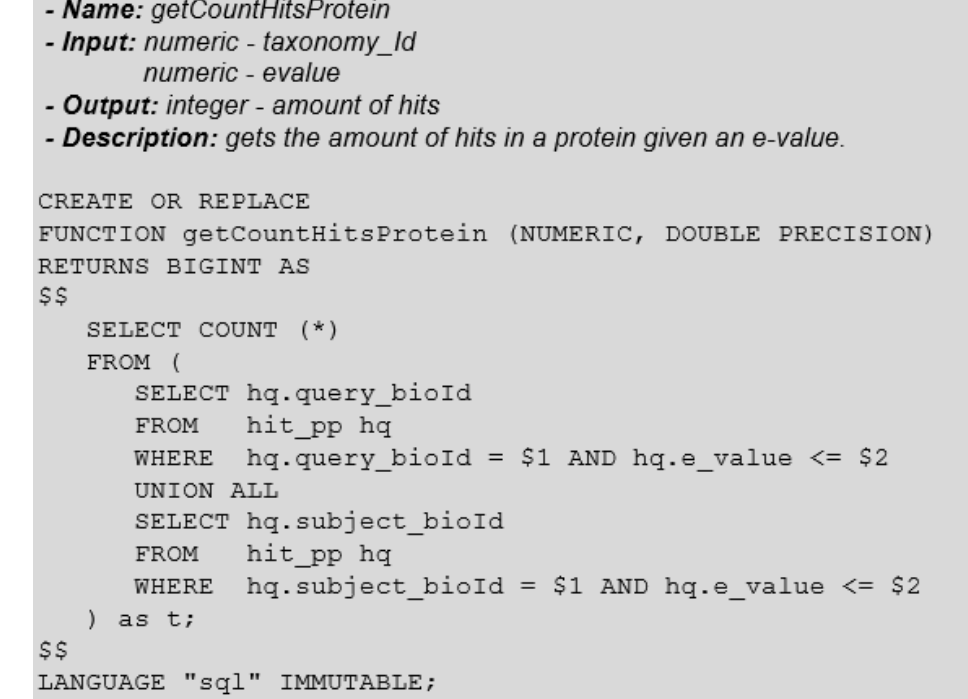
Figure 12. Function: